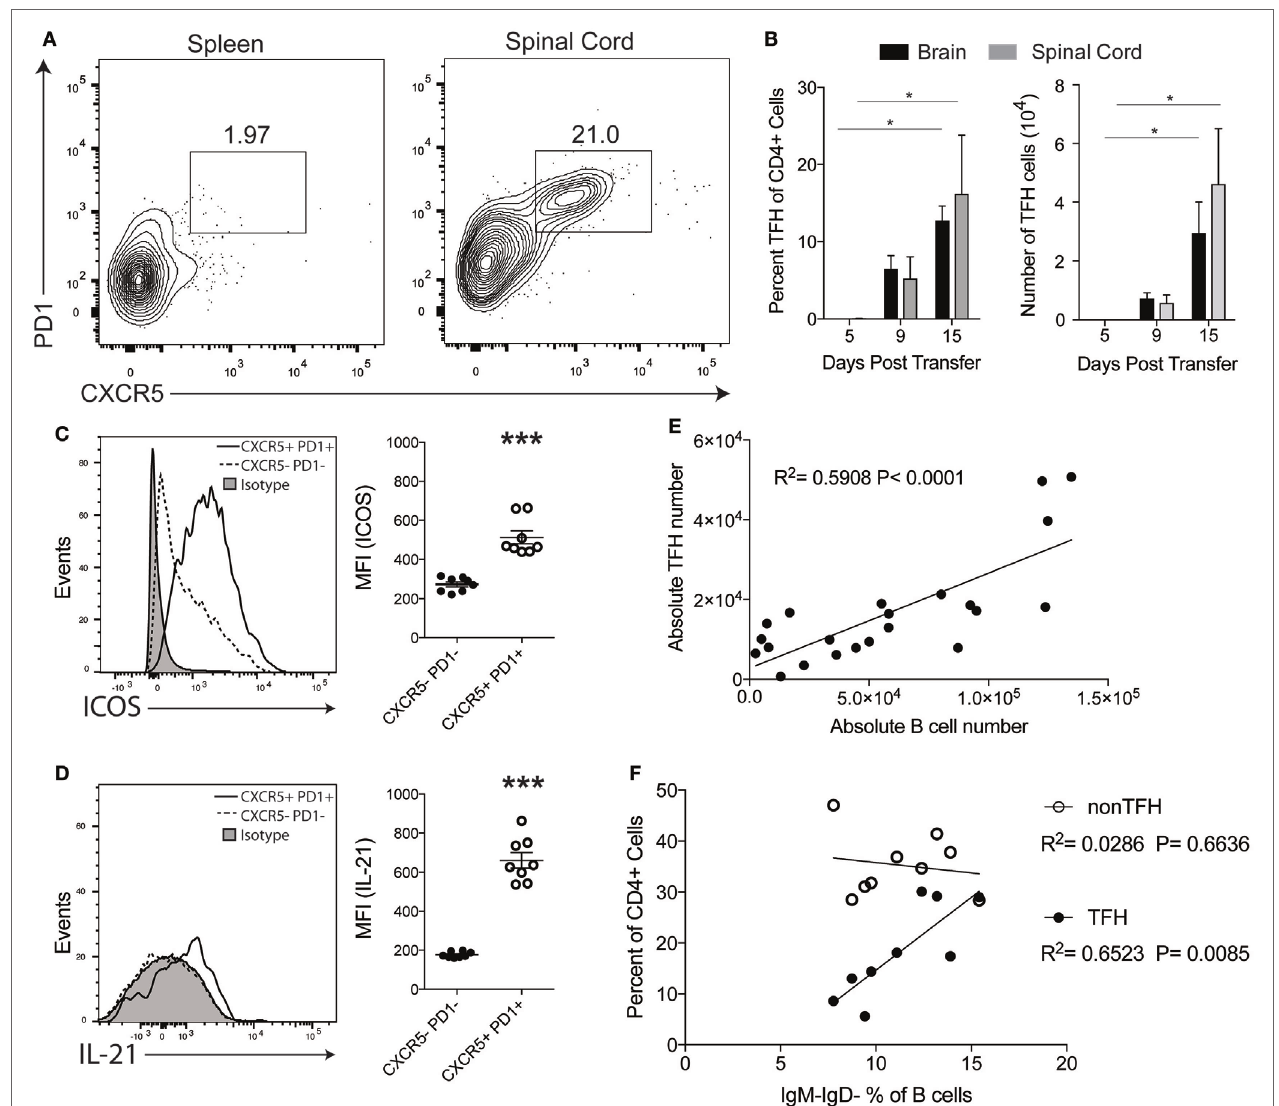
FigUre 3 | CXCR5 + TFH cells are present in the central nervous system (CNS) of TH17-experimental autoimmune encephalomyelitis (EAE) mice. (a) Representative flow cytometry plots of CXCR5 + PD1 + CD4 + T cells in the spleens and spinal cords of mice with TH17-EAE mice at Day 15 post-transfer. Gated on the total viable CD4 + cell population. (B) Percentage of CD4 + cells and absolute number of CXCR5 + PD1 + CD4 + T cells infiltrating the spinal cord and brain of TH17-EAE. Statistical significance from Day 5 to Day 15 was determined using Kruskal–Wallis test (* p < 0.05). Data are from one experiment representative of two experiments ( N = 3 mice per group/experiment). (c) Expression levels of ICOS (measured by mean fluorescent intensity) in CXCR5 + PD1 + CD4 + T cells and CXCR5 − PD1 − CD4 + T cells was determined by flow cytometry. Statistical significance was determined using Student’s t -test (*** p < 0.0001) and N = 8. (D) Expression levels of intracellular IL-21 (measured by mean fluorescent intensity) in CXCR5 + PD1 + CD4 + T cells and CXCR5 − PD1 − CD4 + T cells was determined by flow cytometry. Statistical significance was determined using Student’s t -test (*** p < 0.0001) and N = 8. (e) Correlation between TFH and B cell numbers was assessed at the peak of disease. Statistically significant correlations were determined using linear regression. Data are compiled from two experiments ( N = 10 mice). (F) Correlation between the percent of CD19 + B220 + IgM − IgD − class-switched B cells (of total CD19 + B220 + population) and the percent of CXCR5 + PD1 + CD4 + T cells and CXCR5 − PD1 − CD4 + T cells (of total CD4 + population) in the CNS tissues was assessed at the peak of disease. Statistically significant correlations were determined using linear regression. Data are compiled from two experiments ( N = 10